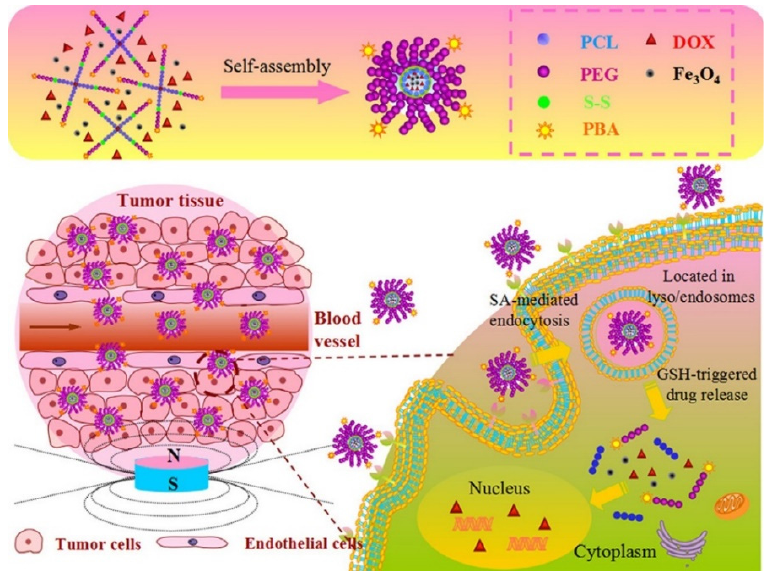
Figure 12. Schematic illustration of the fabrication of DOX-loaded magnetic star-shaped polymer micelles and the procedure to selectively target the SA-positive HepG2 cells by the dual-targeting, and the fast response by GSH on drug release in the cytoplasm (Reprinted with permission from Ref. [77]. 2016, Zhaomin Tang).